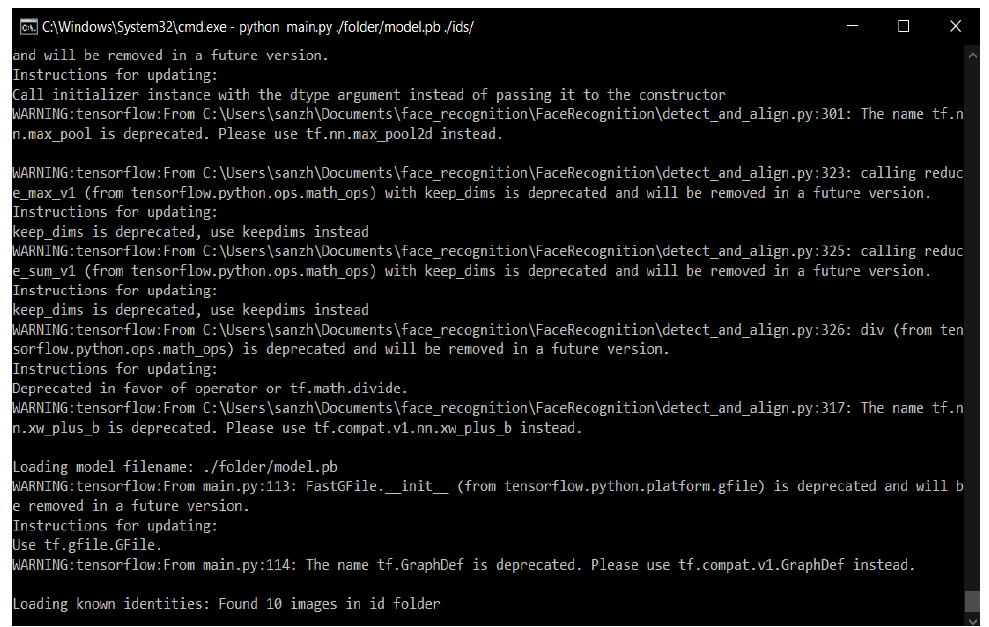
Figure 2. Result of folders availability. These lines (Algorithm 2) show the distance between the object and the camera (Algorithm